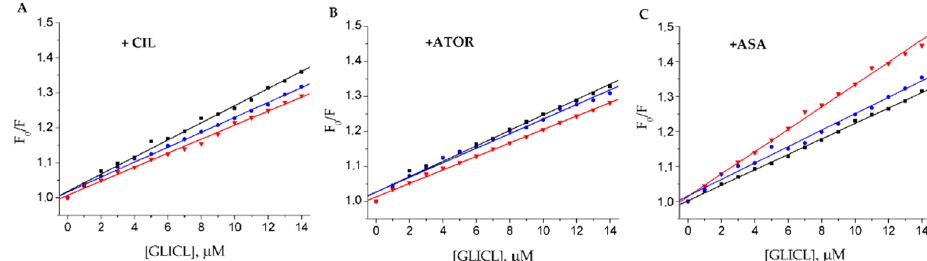
Figure 5. The Stern-Volmer plots for the interaction of gliclazide with BSA in the presence of ci- lazapril ( A ), atorvastatin ( B ) and acetylsalicylic acid ( C ): native BSA ( ■ ), g10_BSA ( ● ), g30_BSA ( ▲ ) at λ ex = 295 nm. Table 1. The calculated values of Stern-Volmer quenching constant (K SV ), binding constant (K a ) and number of bound gliclazide (n) for tested ternary drug models at λ ex 295 nm (mean ± SD). Drug